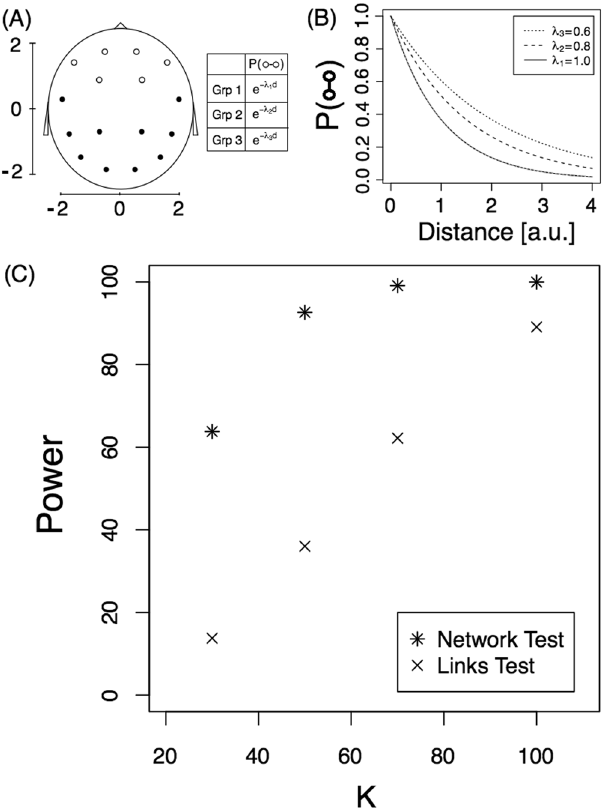
Figure 1. Detection problem. ( A ) Diagram of the scalp (each node represent a EEG electrode) on an x-y scale and the link probability. The three groups confirm the equation P ( ○ ↔ • ) = P ( • ↔ • ) = e − d . ( B ) Link probability of frontal electrodes, P ( ○ ↔ ○ ), as a function of the distance for the three subpopulations. (C) Power of the tests as a function of sample size, K . Both tests are